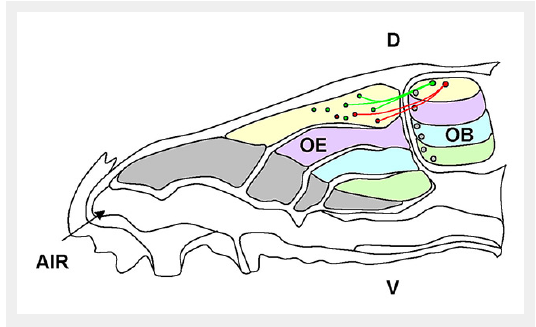
Schematic of the olfactory sensory neuron (OSN) projections to the olfactory bulb (OB). The olfactory epithelium (OE) is divided in zones along the dorsoventral axis, which are defined by the expression of the odorant receptors (ORs). OSNs expressing the same receptor (red or green) are confined within a zone and project their axons to a corresponding area (along the dorsoventral axis) of the olfactory bulb. D = dorsal; V =